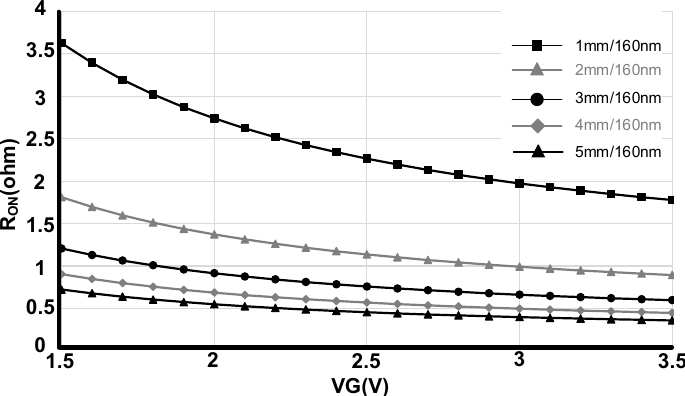
Figure 3. R ON of the transistor with respect to the size and gate voltages.